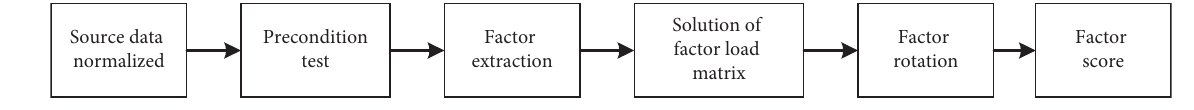
Figure 6: Basic steps of factor analysis. Table 3: Standardized indicators.